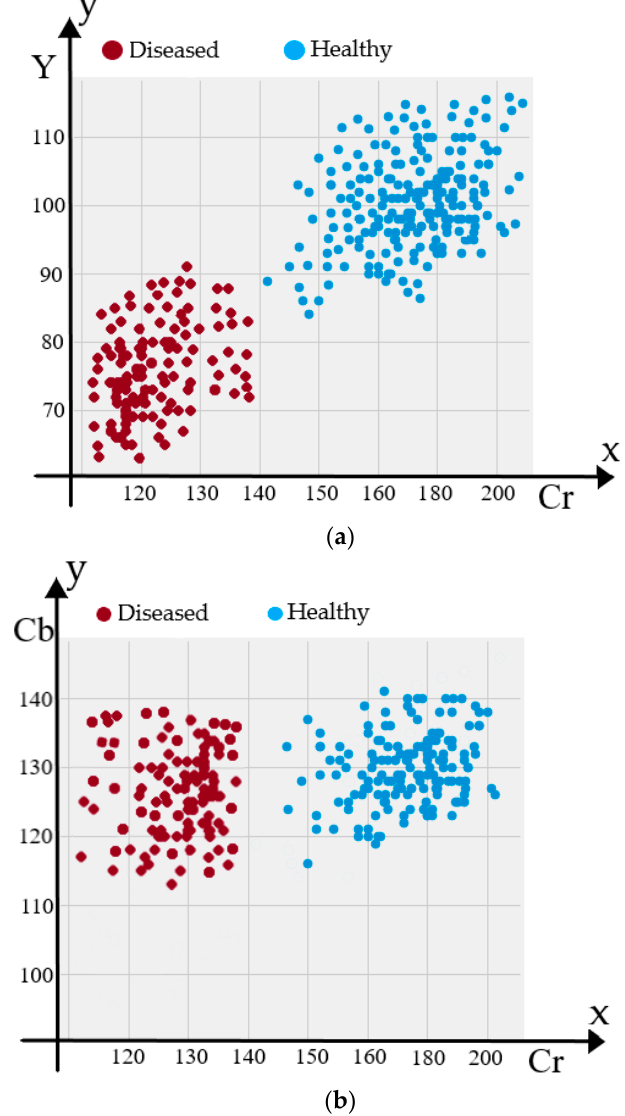
Figure 11 . Color distribution of different color channels in healthy and diseased throats: ( a ) Y and Cr color intensity distribution of healthy and strep throats, and ( b ) Cb and Cr intensity distribution of healthy and strep throats.